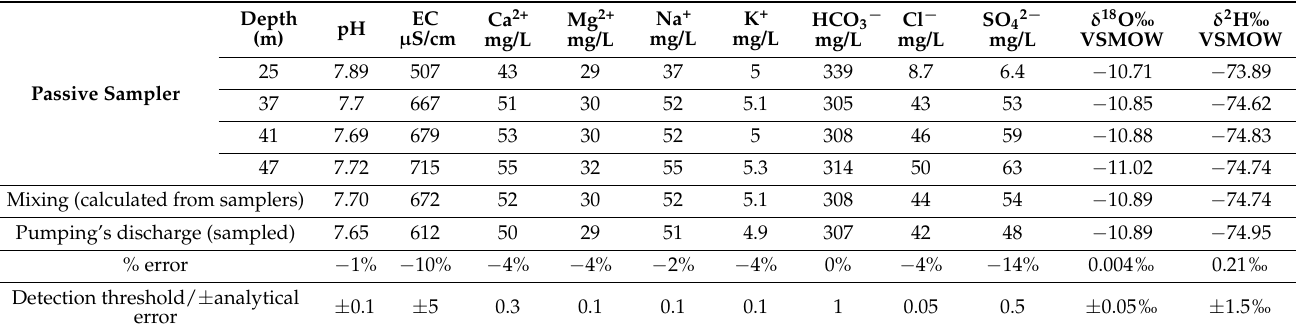
Table 3. Comparison of passive sampling with samples collected at the pumping discharge of the Chateauguay wellbore.